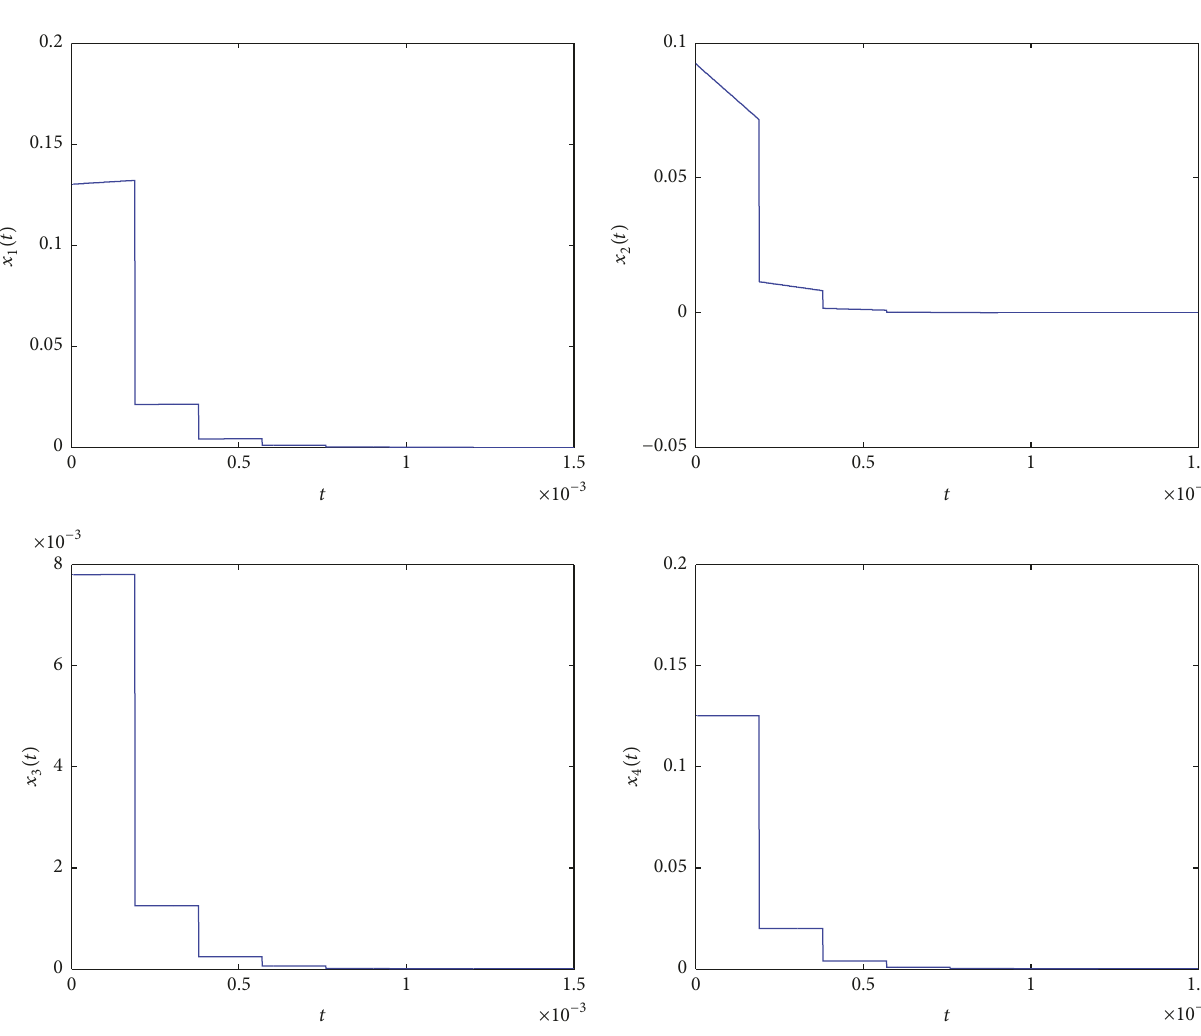
Figure 4: The state trajectory of the controlled memristor based chaotic